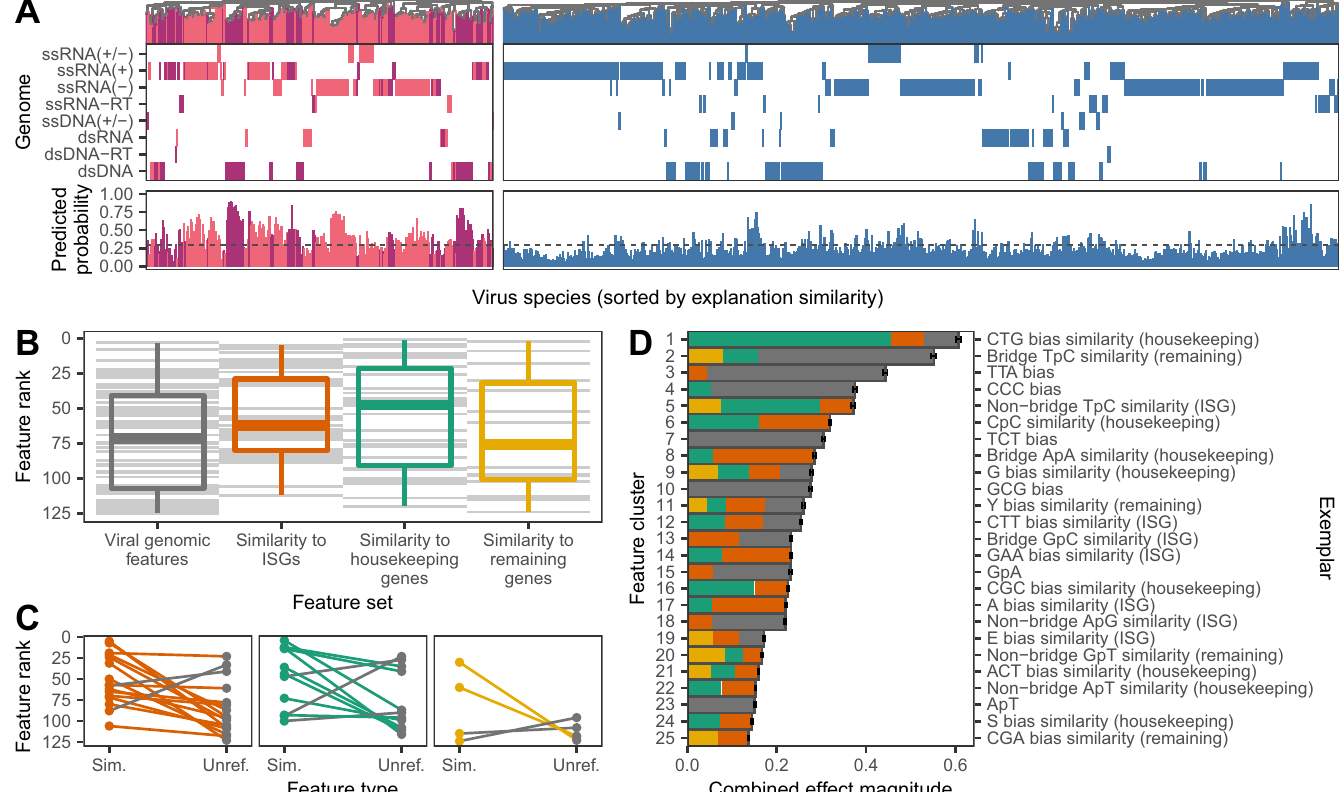
Fig 2. Genomic determinants of human-infecting viruses. (A) SHAP value clustering of viruses known to infect humans (primarily human associated, dark purple, and zoonotic, pink) and those with no known history of human infection (blue) shows that similar features predicted human infection across viruses with different genome types (rows). A second set of panels shows the predicted probability of infecting humans for each virus, with the dashed line indicating the cutoff that balances sensitivity and specificity. (B) Relative importance of individual features in shaping predictions, determined by ranking features by the mean of absolute SHAP values across all viruses. Gray lines represent individual features; boxplots show the median, 25 th /75 th percentiles, and range of ranks for each feature set. (C) Difference in ranks of features when both unreferenced (“Unref.”) and similarity to human genomes (“Sim.”) forms were retained in the final model. Lines are colored according to the highest ranked representation in each pairwise comparison; colors as in B. (D) Composition of the top 25 most important clusters of correlated features shaping predictions. Discrete clusters of correlated features were identified by affinity propagation clustering. Clusters are shown ranked by the combined effect magnitude of constituent features, defined as the sum of mean absolute SHAP values for all features in the cluster, and the exemplar feature of each cluster is provided on the right axis. Bars represent means ( ± SEM) across 1,000 iterations and are shaded by the proportion of the cluster from each feature set; colors as in B. Numerical data underlying this figure can be found at https://github.com/nardus/zoonotic_rank/tree/main/FigureData (doi: 10.5281/zenodo.4271479). SHAP, SHapley Additive